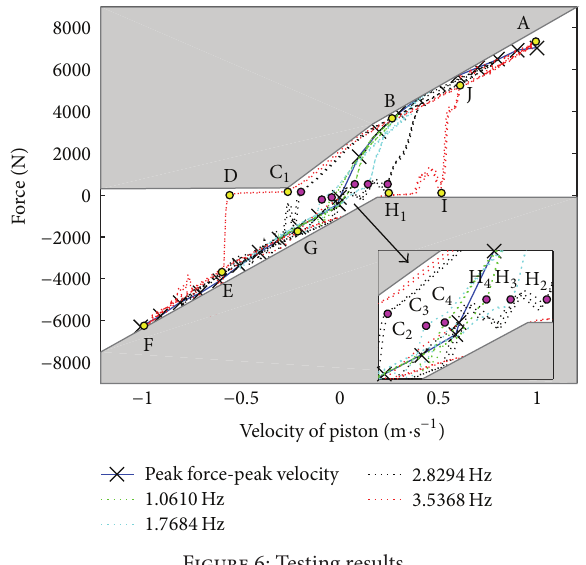
Figure 6: Testing